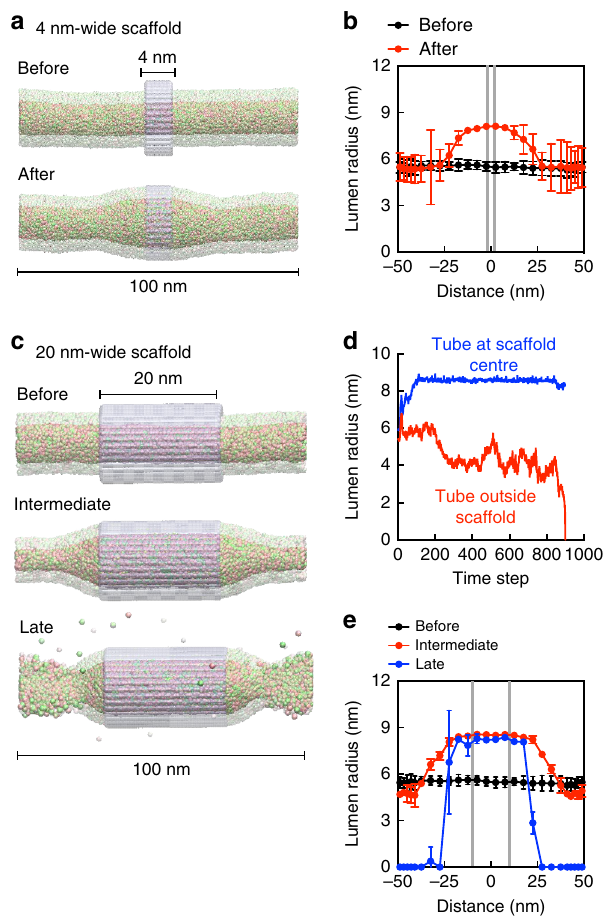
Fig. 8 Molecular dynamics simulations of scaffold-induced tube bulging and fi ssion. a Frames from simulations of a 4 nm-long scaffold (magenta) on a 100 nm-long membrane tube. Cream and green spheres represent headgroups of DOPS and DOPC lipids, respectively. Light and dark spheres represent headgroups of lipids on the outer and inner lea fl et, respectively. Only lipid head groups are shown for clarity (see Supplementary Movie 4). b Lumen radius along the tube length upon placement of a 4 nm-long scaffold. Data represent the mean with variance. Gray lines represent scaffold boundaries. c Frames from simulations of a 20 nm-long scaffold on a 100 nm-long membrane tube. Cream and green spheres represent headgroups of DOPS and DOPC lipids, respectively. Light and dark spheres represent headgroups of lipids on the outer and inner lea fl et, respectively. Only lipid head groups are shown for clarity (see Supplementary Movie 5). d Evolution of lumen radius at the middle (blue) and at the site of maximum thinning (red) after placement of a 20 nm-long scaffold. X -axis is in units of 10,000 τ , where τ is a CG time step. e Lumen radius along the tube length upon placement of a 20 nm-long scaffold. Data represent the mean with variance. Gray lines represent scaffold